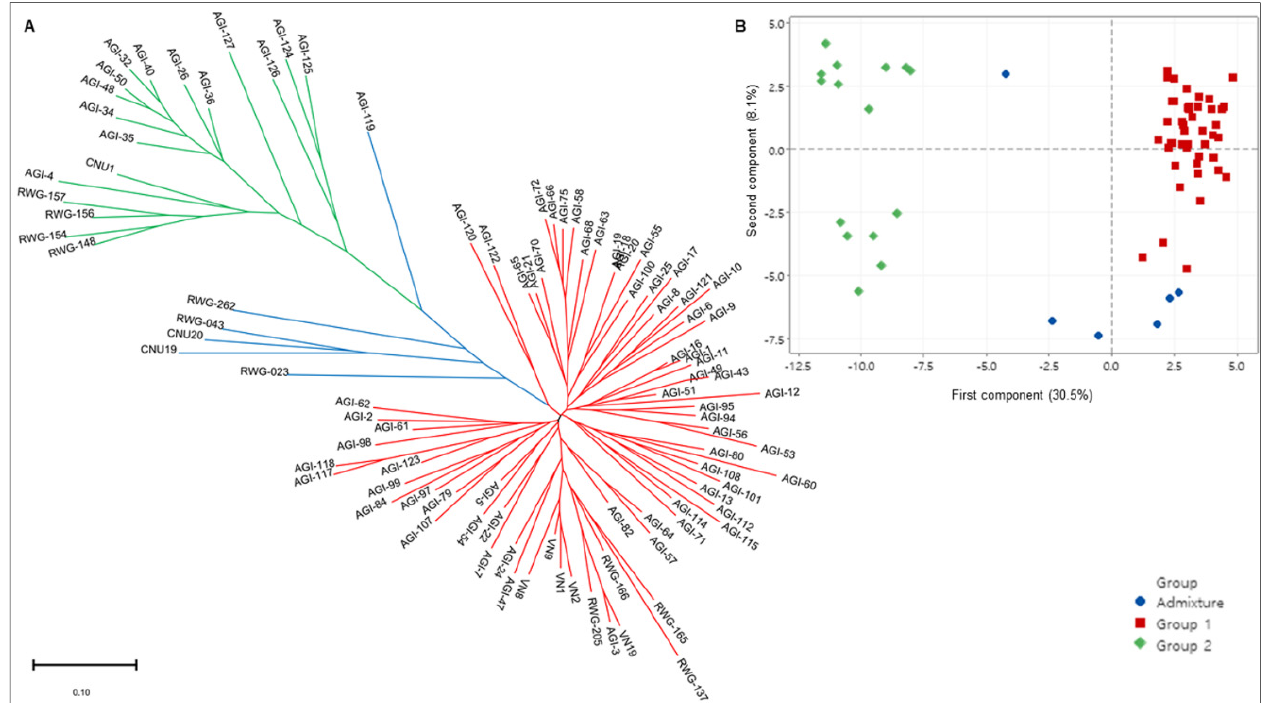
Figure 3. Visualization of population structure and number of subgroups within the population. ( A ) Clustering results based on Neighbor-Joining method representing Nei’s distance; ( B ) the scatter plot of first (PC1) and second (PC2) marker-derived components estimated by MINITAB software. Each point corresponds to a rice accession. Each color in (A, B) represents a subgroup.